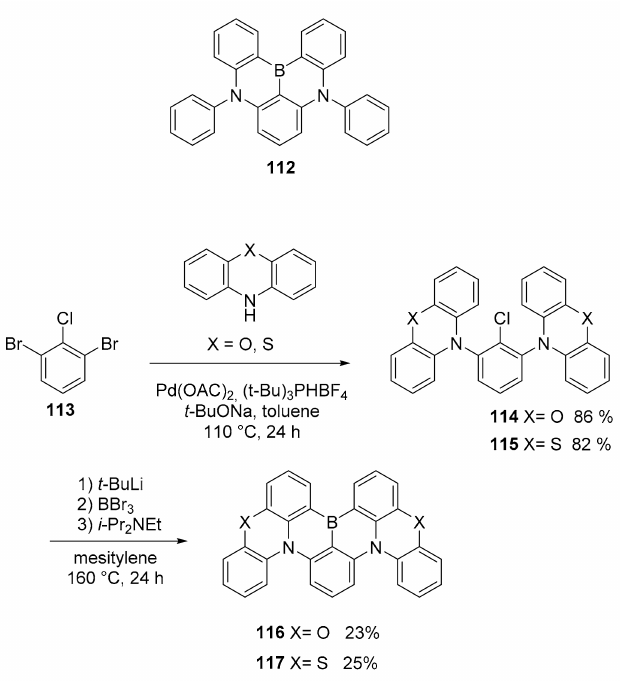
Scheme 30. Structures of compounds 116 – 117